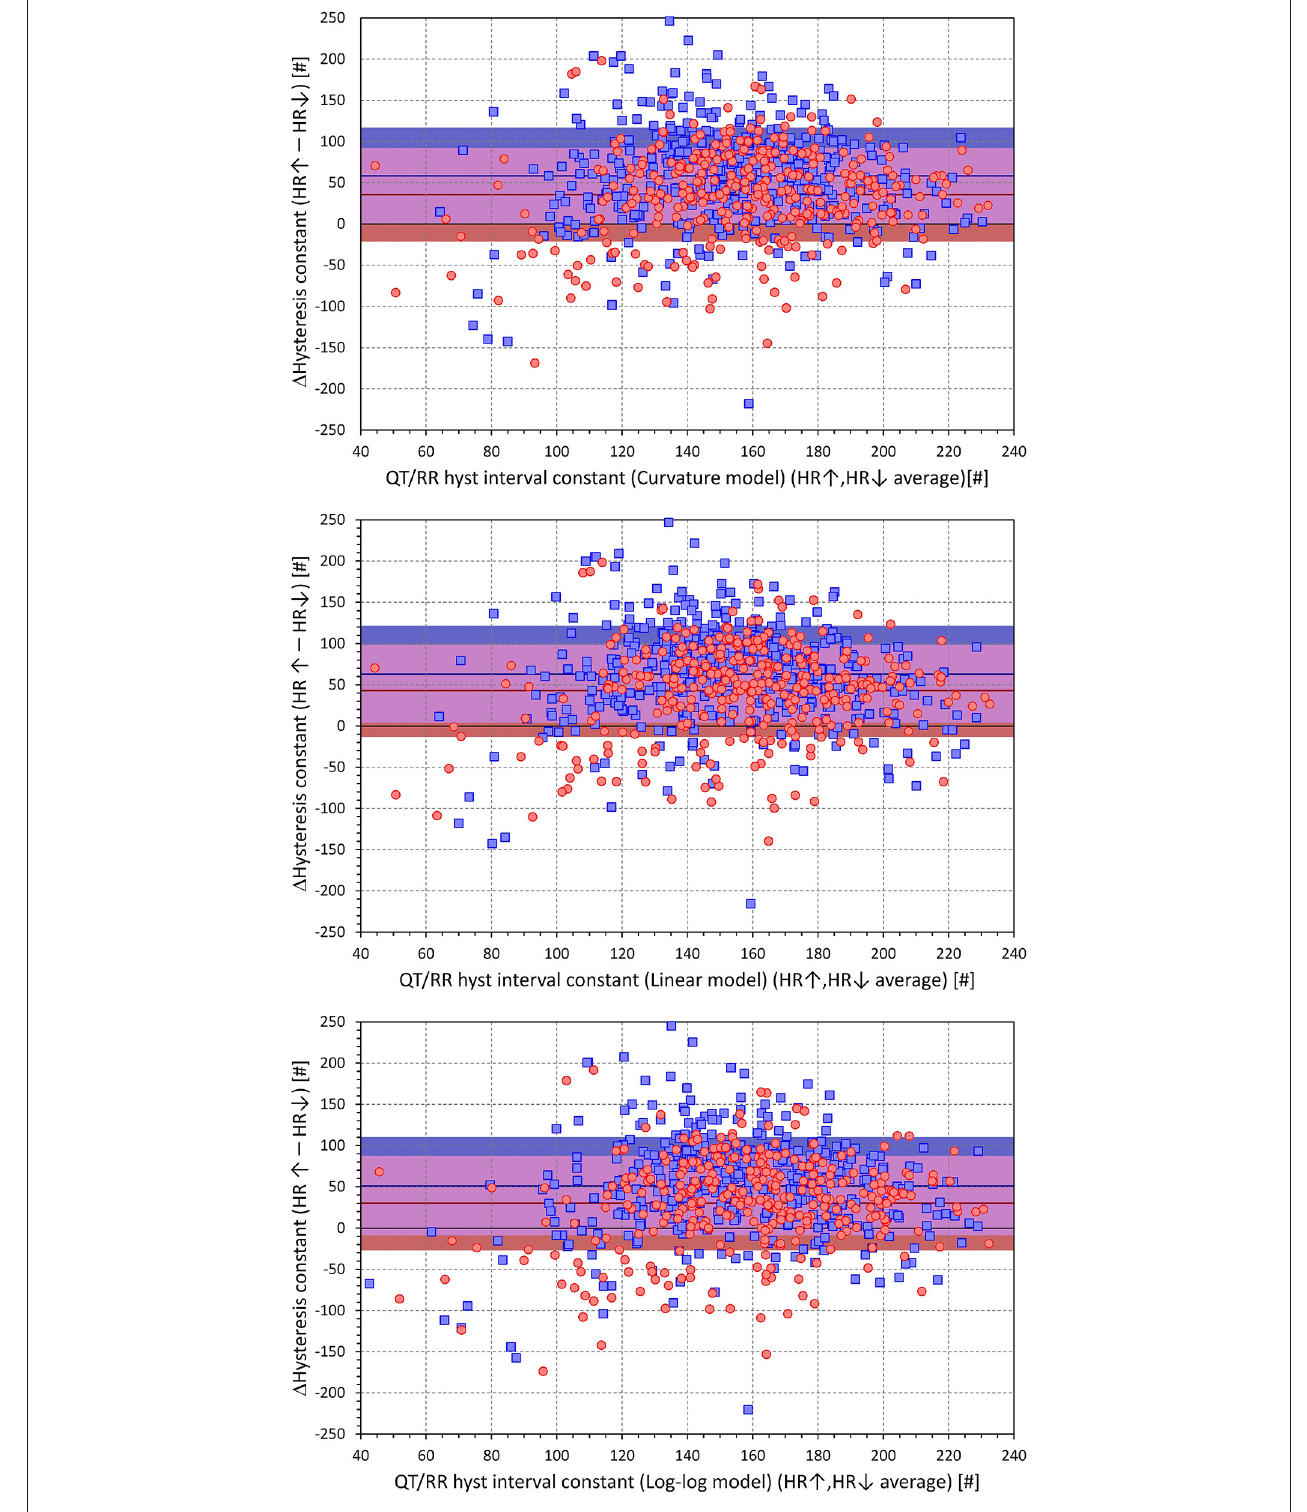
FIGURE 14 | Scatter diagrams of subject-specific differences among hysteresis interval constants during heart rate acceleration and deceleration plotted against their intra-subject averages. The top, middle, and bottom panels show the differences for the curvature, linear, and log-log QT/RR H models, respectively. In each